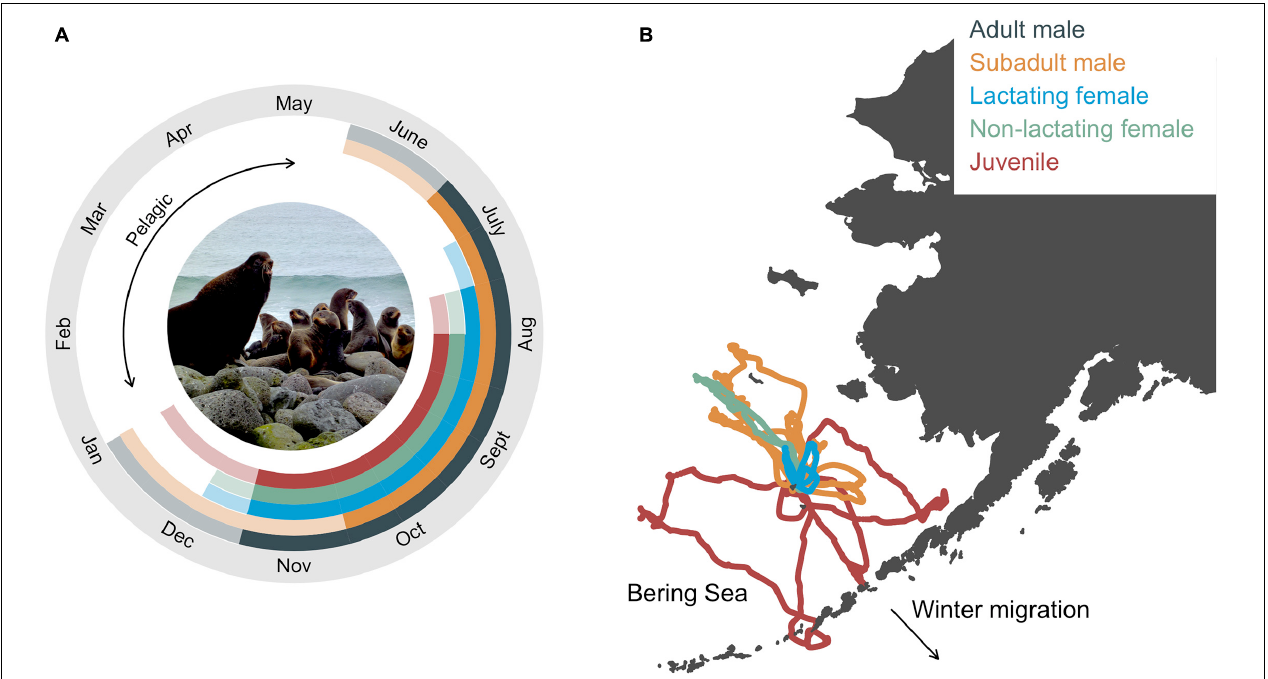
FIGURE 1 | Annual life cycle of northern fur seals by group with inset photograph showing the size dimorphism between an adult male and lactating females (A) and example foraging trips from satellite telemetry of seals in each group (except adult males, B ). In (A) , solid colors correspond to the time between the mean arrival and departure time of seals in each group, representing the time when most fur seals in each age group were present in the bioenergetic model simulations. Transparent colors correspond to the time between the minimum allowable arrival and maximum departure dates, which in conjunction with the solid colors, represent the total allowable time fur seals in each age group were present in the bioenergetic model simulations. In (B) , example foraging trips were from seals instrumented at the same rookery. Photograph by R. Ream (AFSC-MML).